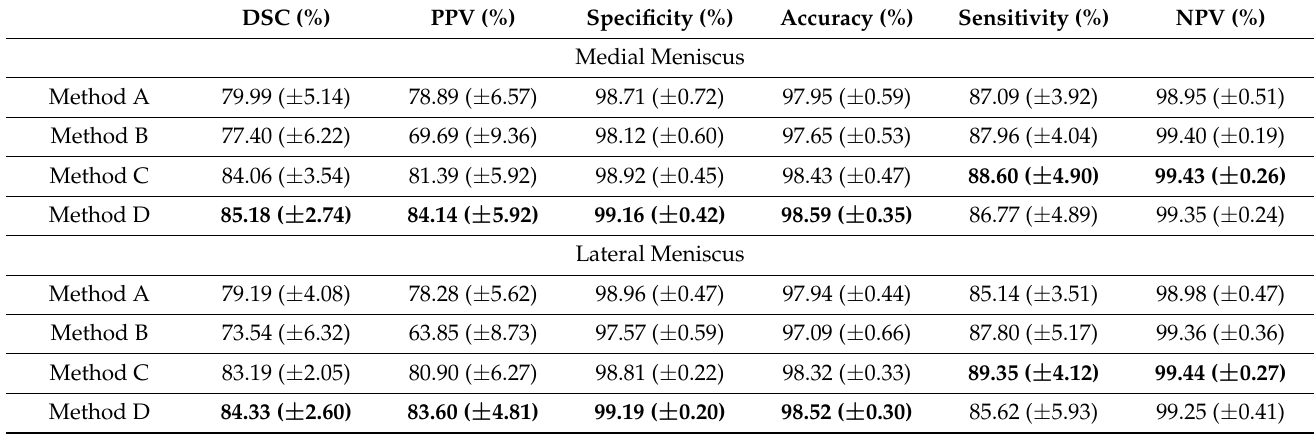
Table 2. Quantitative evaluation of medial and lateral meniscus segmentation results (bold indicates the best performance of the comparison